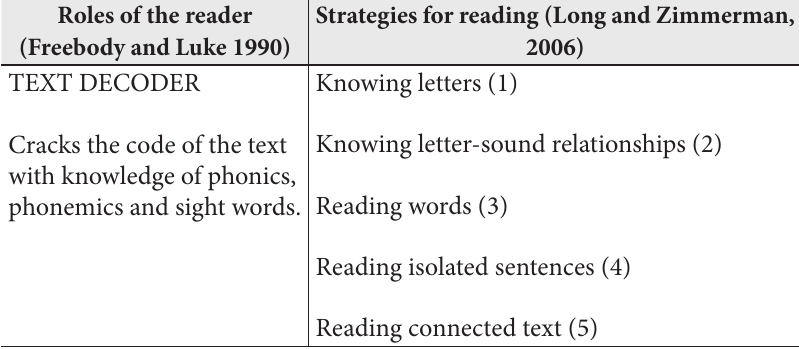
Table 1: Text strategies aligned with the roles of the reader Roles of the